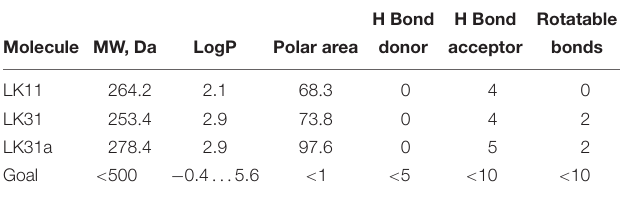
TABLE 2 | Chemical properties of pyoverdine inhibitors.